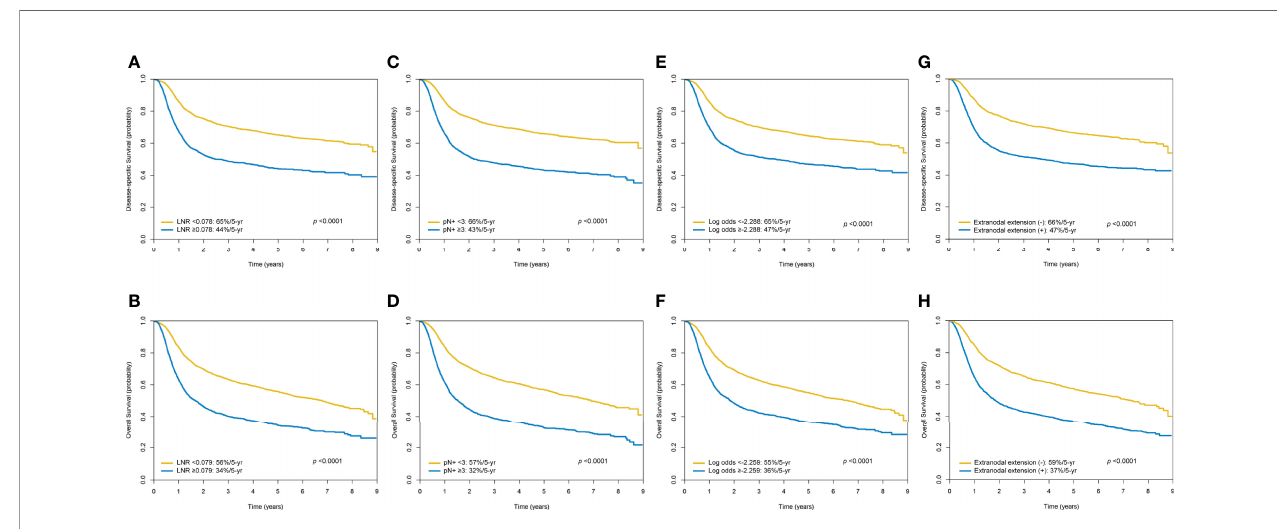
FIGURE 3 | Kaplan-Meier plots of 5-year disease-speci fi c survival and overall survival according to the lymph node ratio (A, B) , the number of pathologically positive nodes (C, D) , the log odds of positive lymph nodes (E, F) , and the presence of extra-nodal extension (G, H) .